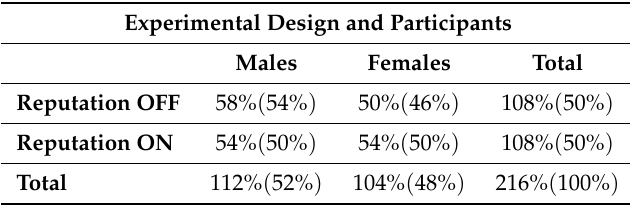
Table 2. Experimental design and number of participants for each condition with gender